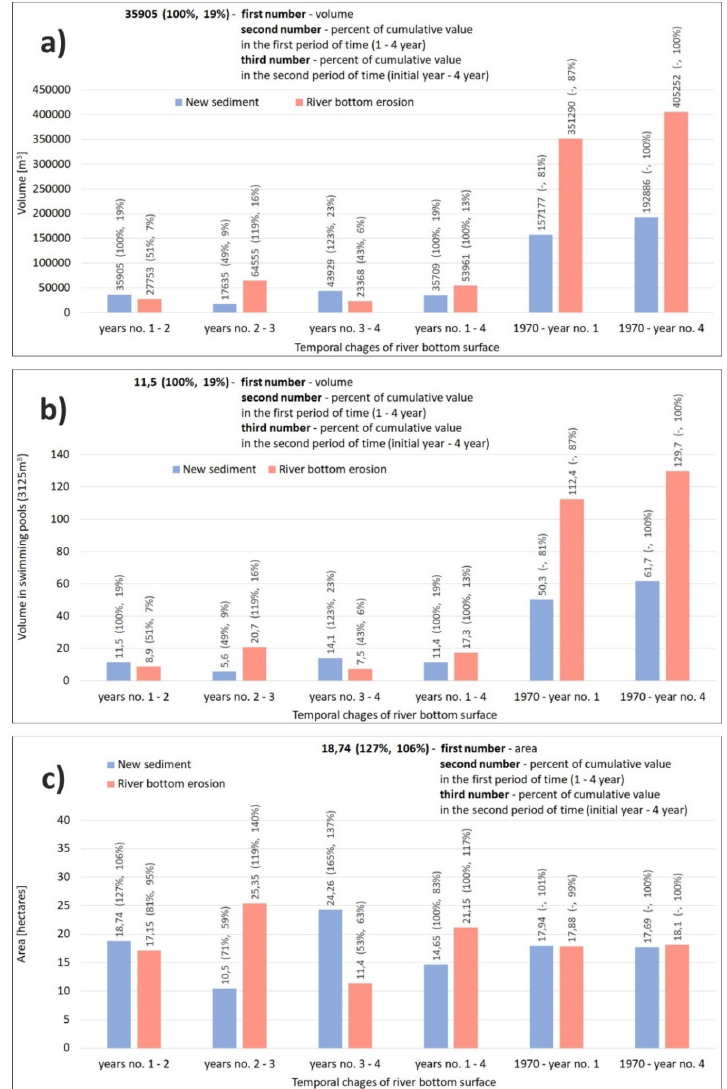
Figure 7. Changes in river bottom erosion and new sediments ( a ) volume (m 3 ), ( b ) volume in the number of Olympic ‐ size swimming pools (3125 m 3 ), ( c ) area (m 2 ).